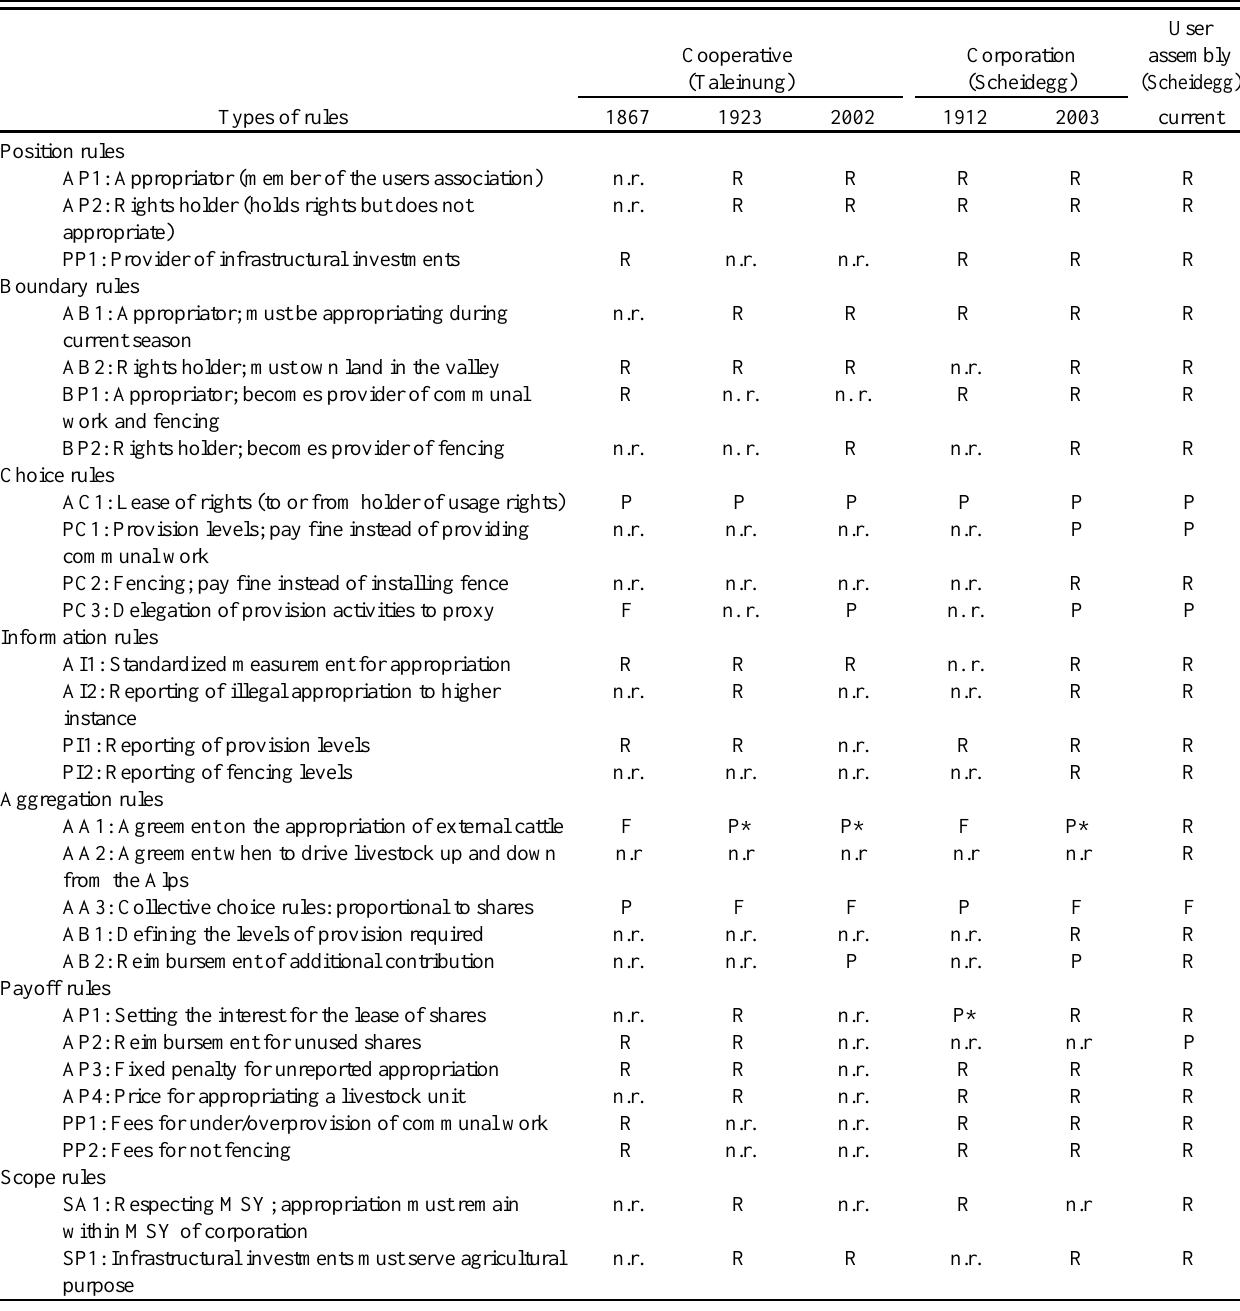
Table 2 . Rule inventory: displays the level that enforces the operational rule at certain points in time. It shows the seven types of operational rules that directly structure the adjacent action situations appropriation (A) and the provision of infrastructural investment (P). The rule codes are as follows: R = the rule must be complied with; P = the rule may be complied with; P* = the rule may be complied with, but agreement from the cooperative board is required; F = the rule does not have to be complied with; n.r. = no rules exist at this time. MSY = maximum sustainable yield.